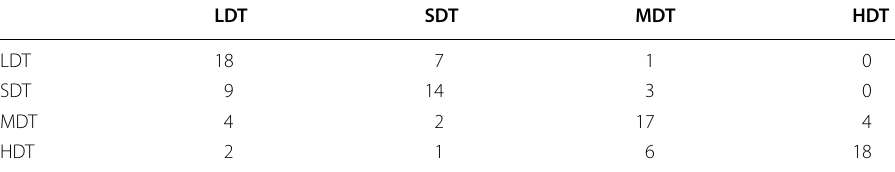
Table 11 Confusion matrix for the Random Forest Predictor